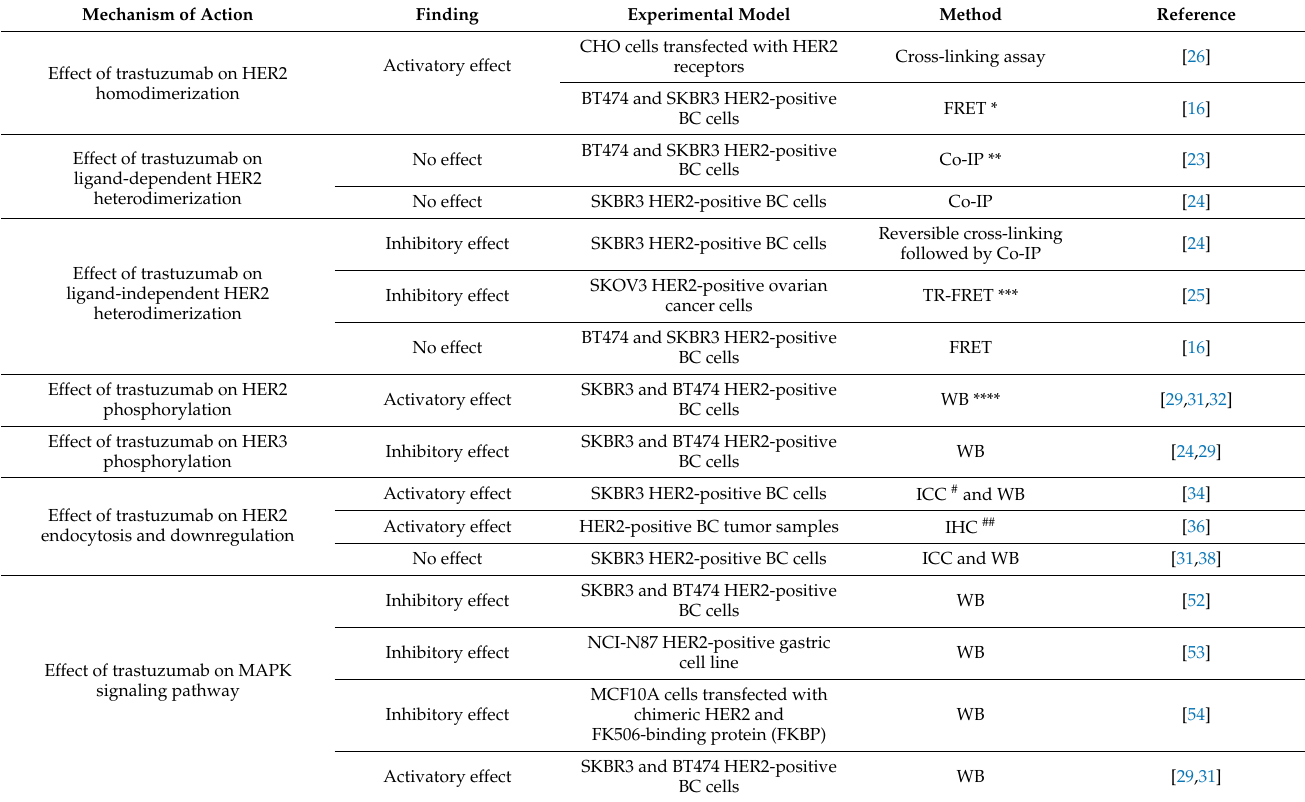
Table 1. The summary of trastuzumab mechanisms of action based on in vitro